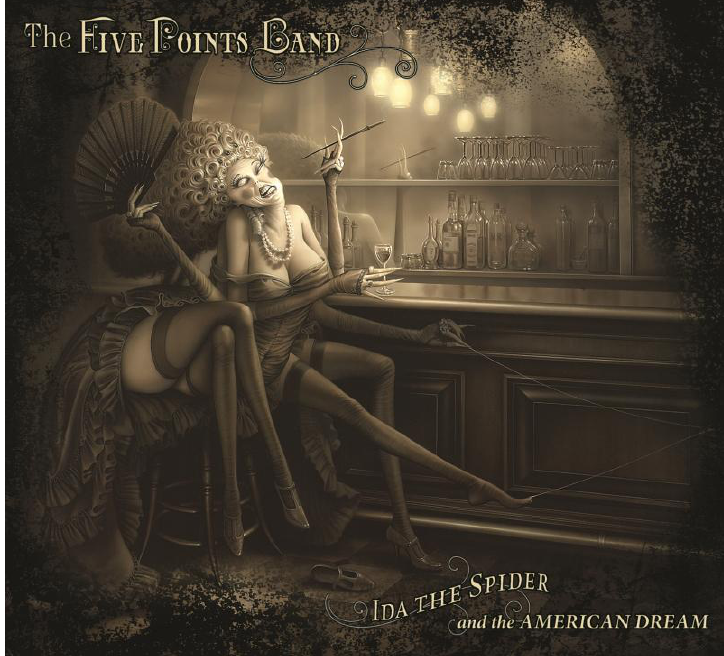
Figure 4. Cover art from The Five Points Band‟s Ida the Spider and the American Dream . Copyright Kirk Reinert; used by